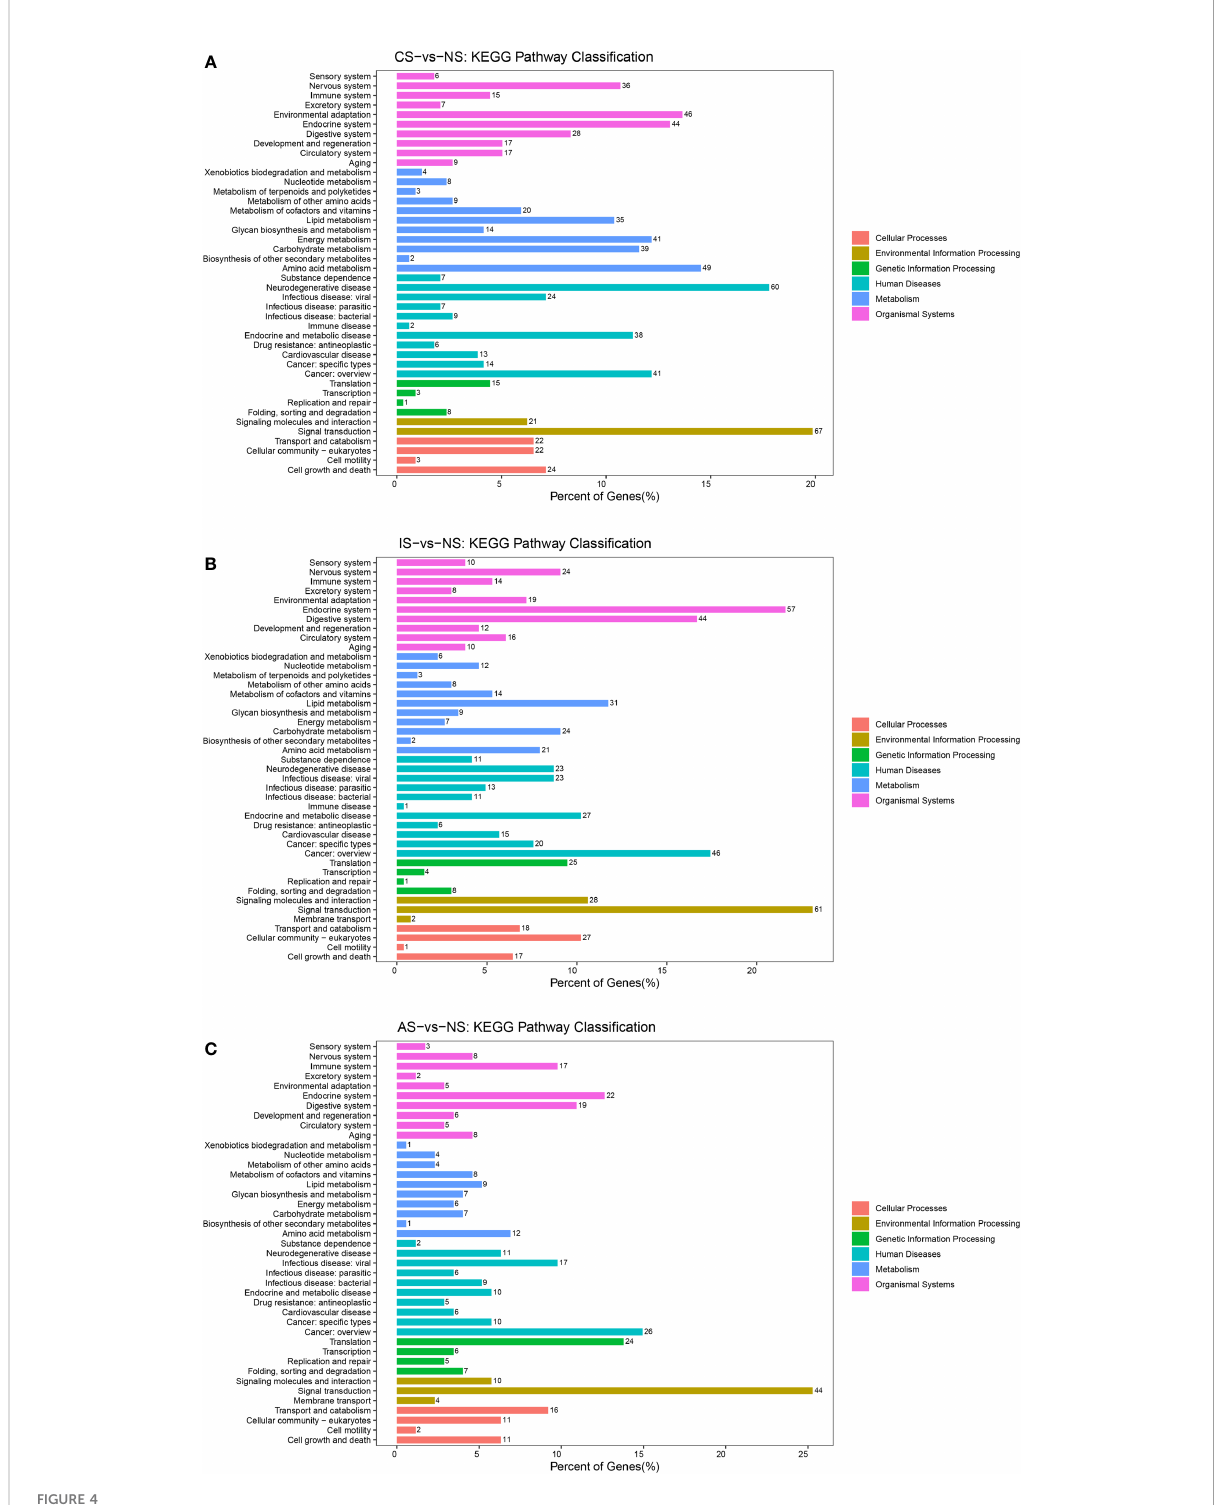
FIGURE 4 KEGG pathways classi fi cation. (A) CS-vs-NS group. (B) IS-vs-NS group. (C) AS-vs-NS group. There were six branches for KEGG pathways: Cellular Processes, Environmental Information Processing, Genetic Information Processing, Human Disease (For animals only), Metabolism and Organismal